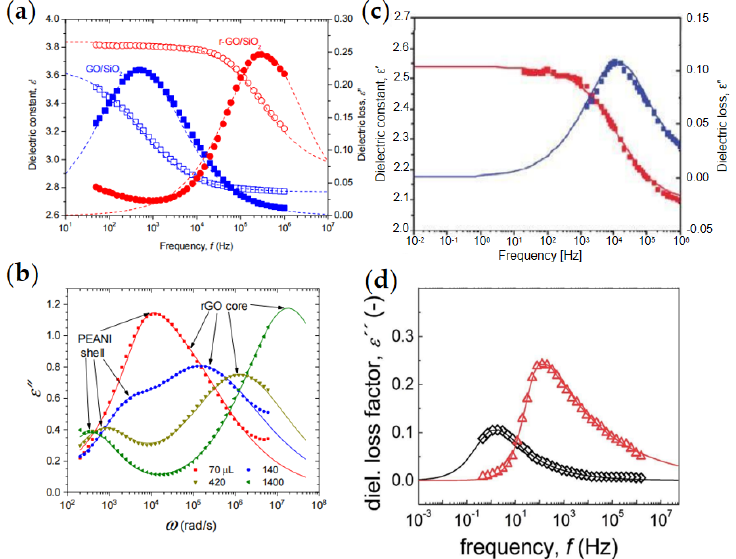
Figure 15. Dielectric spectra of ER fluids. ( a ) GO/SiO 2 and rGO/SiO 2 [68]; ( b ) PEANI/rGO with different reduction degree [86]; ( c ) GO [70]; ( d ) GO ( ◇ ), and GO/PBMA ( △ ) [79]. As the oxide of graphene, GO contains a large number of oxygen ‐ containing groups on its surface, which form defects on the surface of graphene to restrict the movement of carriers and make GO have strong dielectric polarization properties. At the same time, both electrical conductivity and dielectric polarization properties are adjustable by reduc ‐